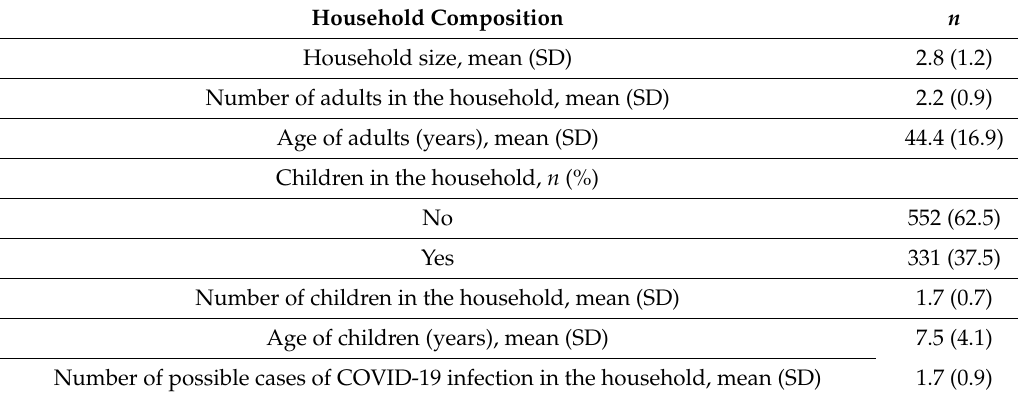
Table 1. Composition of the 883 households in the Haut-Rhin department with at least one possible COVID-19